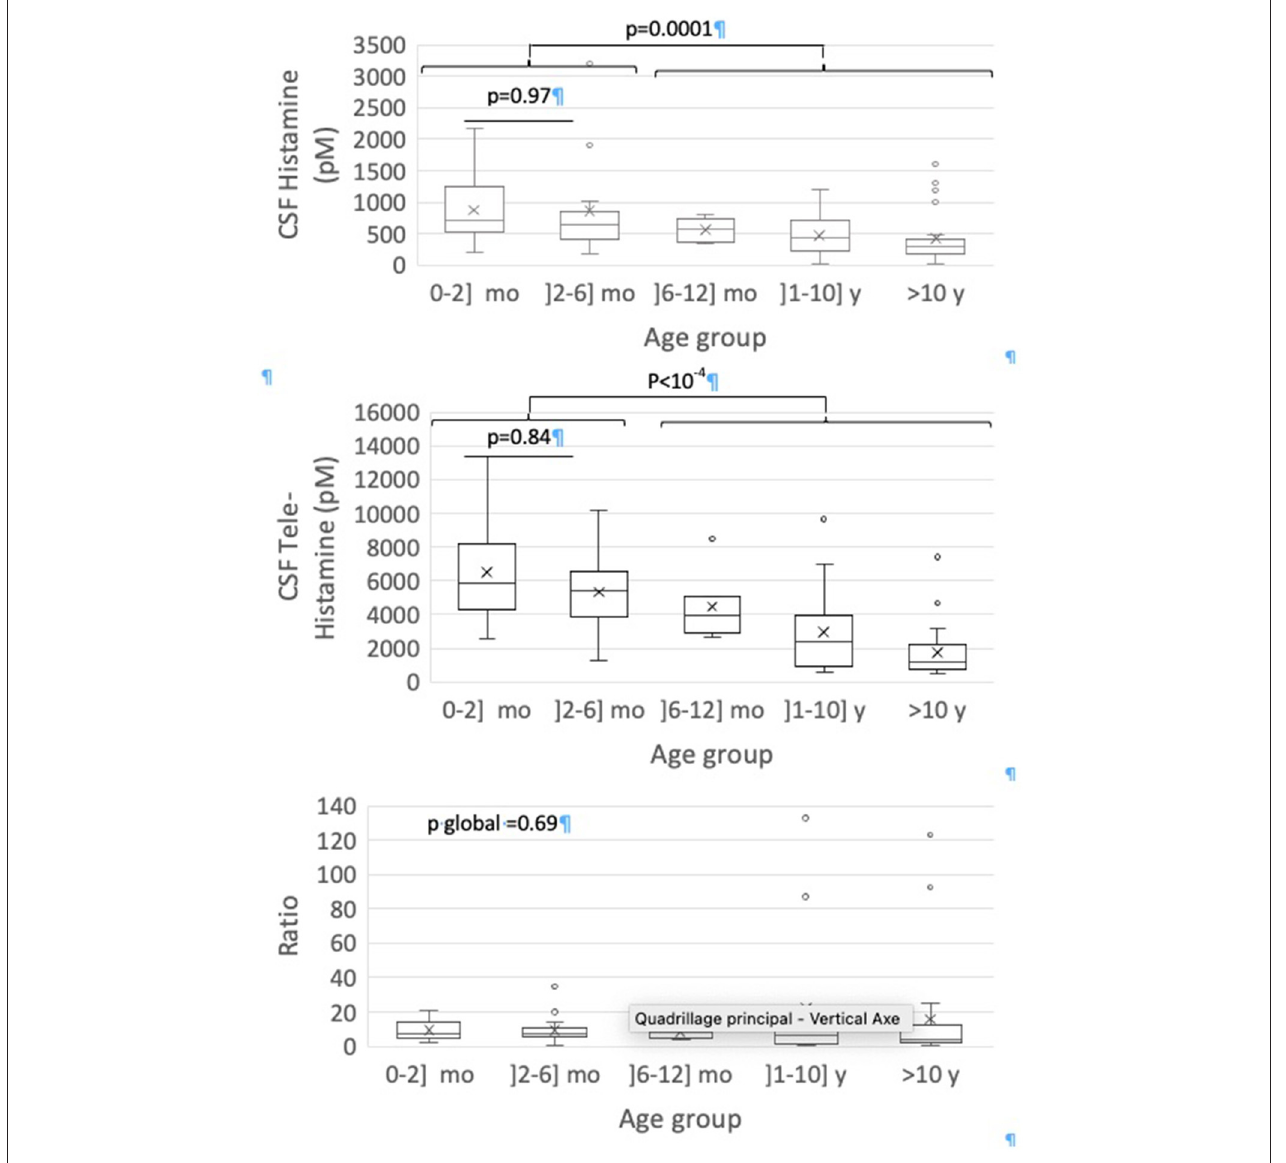
FIGURE 1 | Box-and-whisker plots for CSF measures according to age groups. The minimum value, 25 th percentile, median, 75 th percentile, and the maximum value are represented. The cross is the mean value.